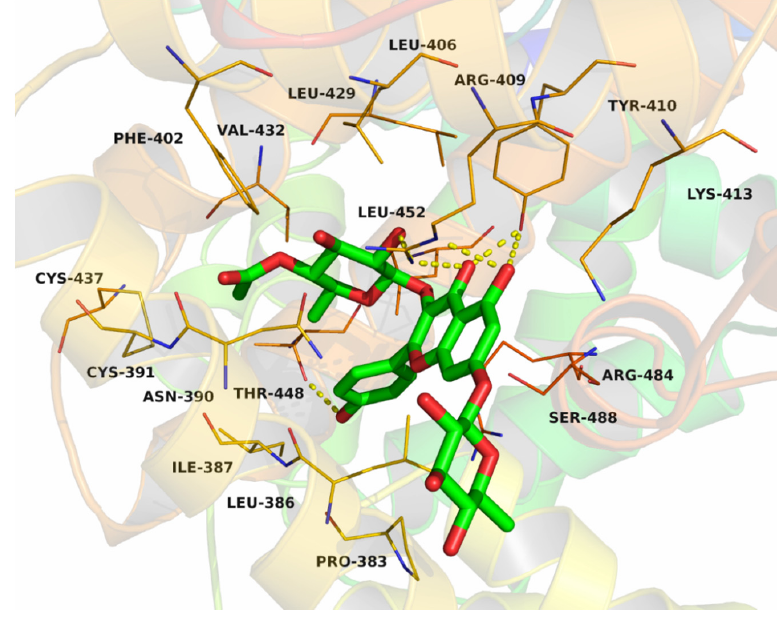
Figure 11. Compound 6 was docked into the Site II (IIIA) binding pocket of the BSA.